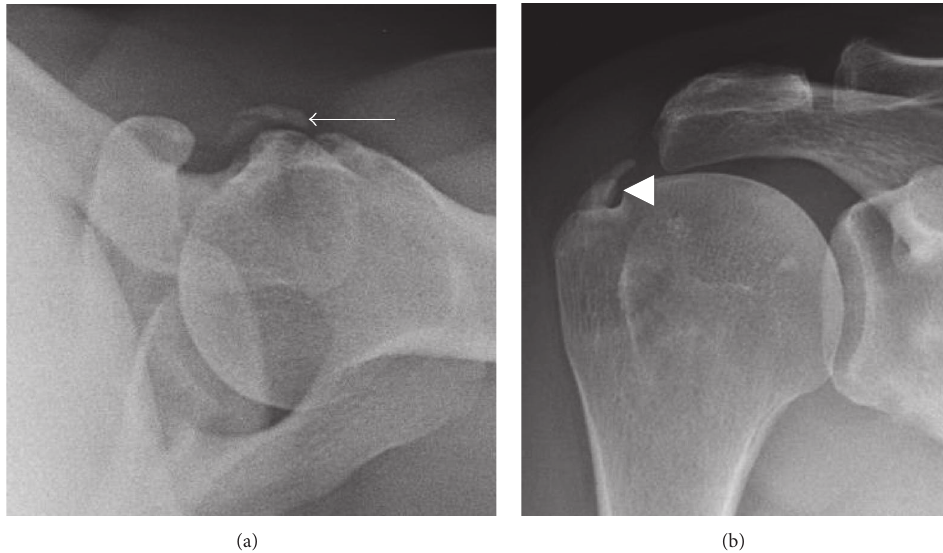
Figure 1: Radiographic appearance of calcific tendinopathy. (a) Fluffy, ill-defined, and inhomogeneous appearance of calcifications (arrow) typical seen in acute symptomatic patients. (b) Discrete, homogeneous, and well-defined appearance of calcifications (arrowhead) typically seen in asymptomatic or chronic symptomatic patients.